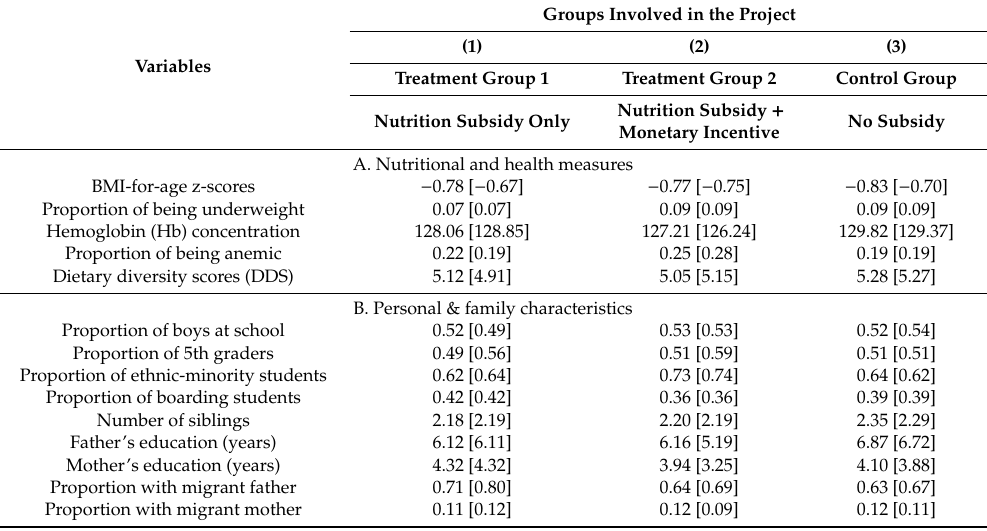
Table A1. Means of baseline characteristics of Grade 4 and 5 students in project